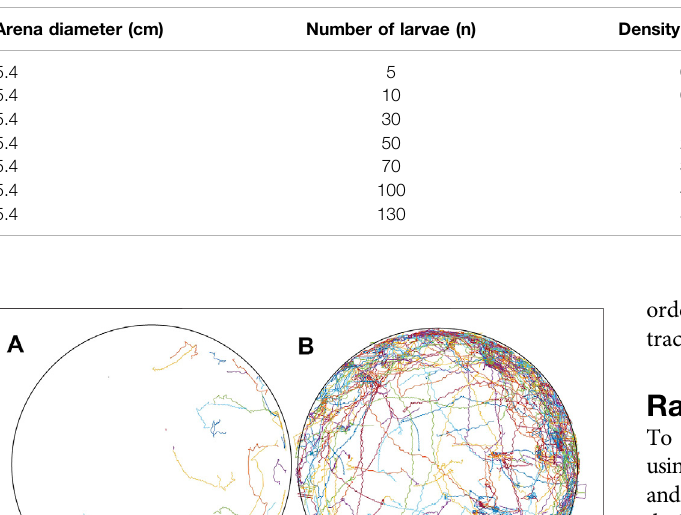
TABLE 1 | Table of density across trial noting when circling behavior was observed.